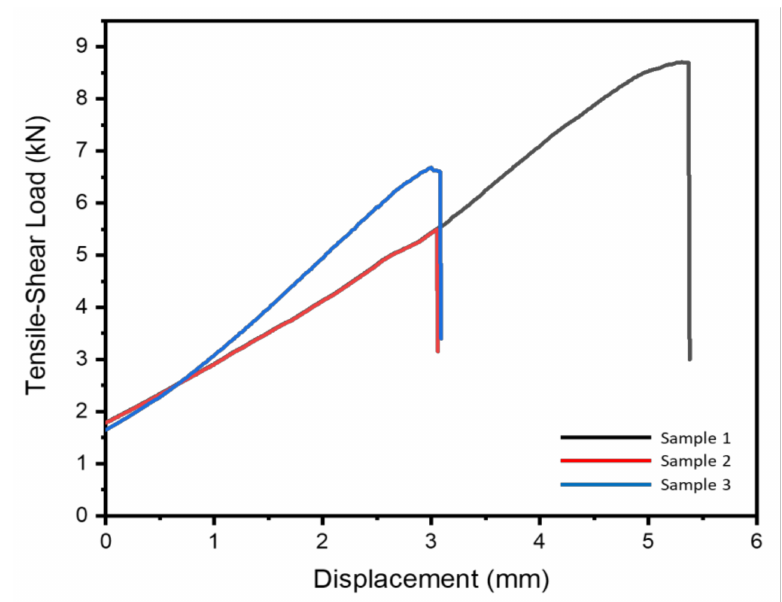
Figure 5. Tensile-shear load graph of the welded